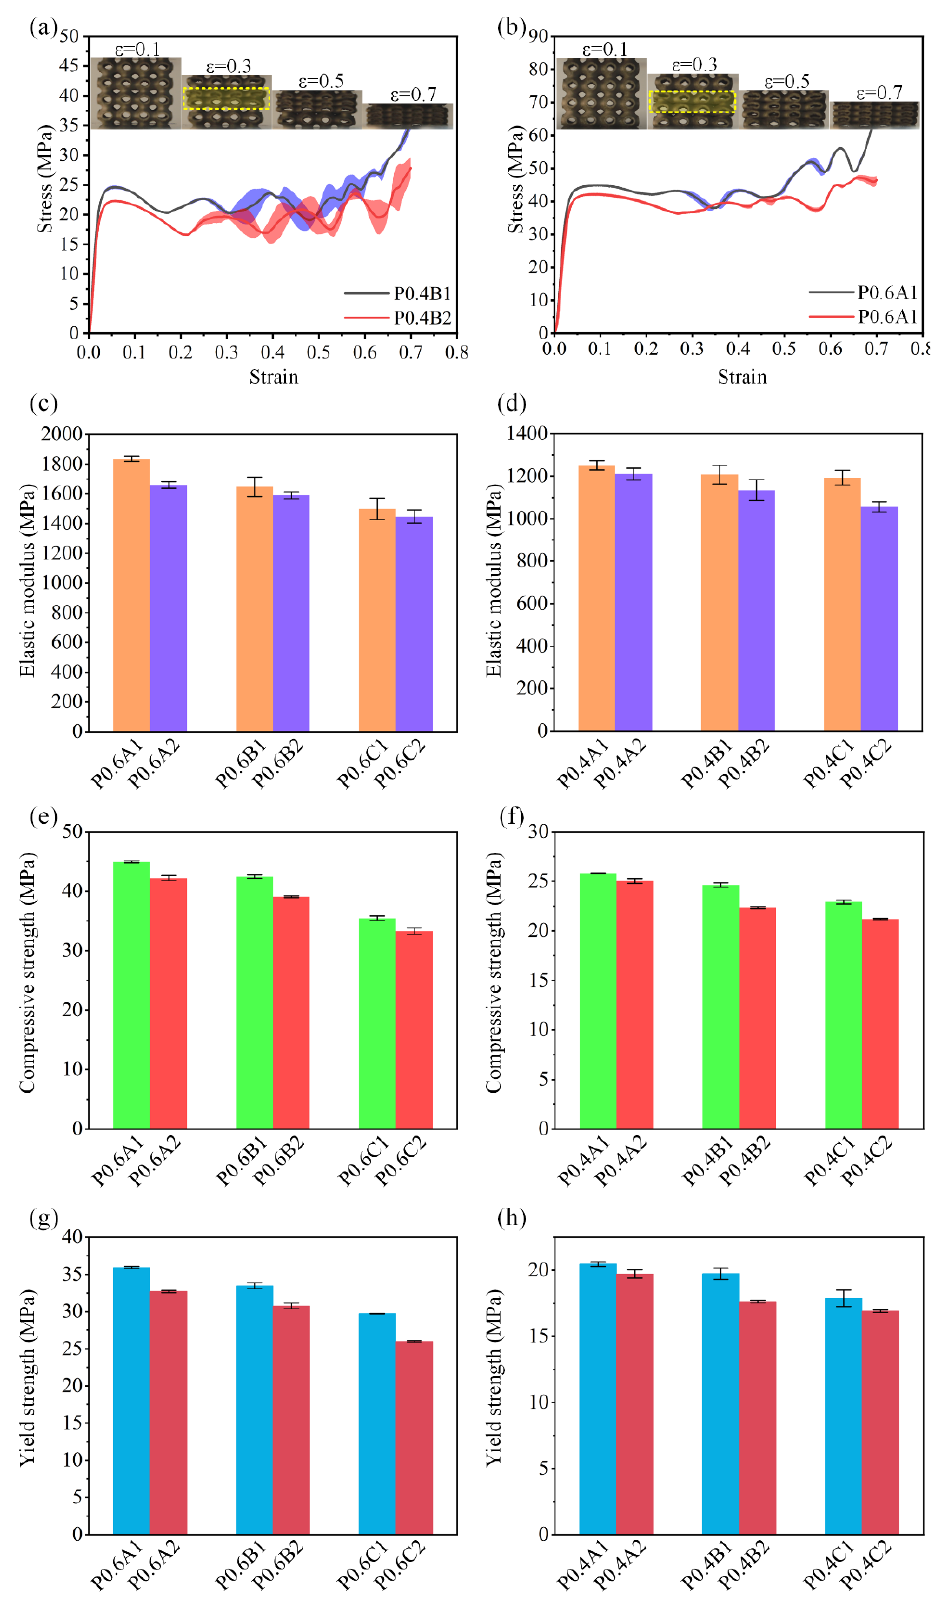
Figure 7. Results of compression tests. ( a , b ) Stress–strain curves of P0.4B1 and P0.6A1. ( c – h ) Comparison of elastic modulus, compressive strength, and yield strength.